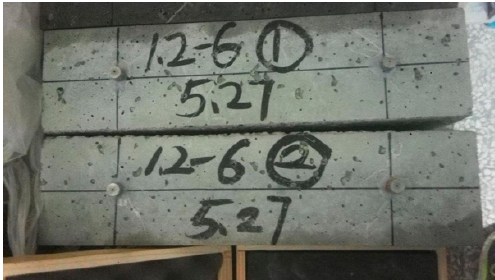
Figure 4. Drying shrinkage test specimens.